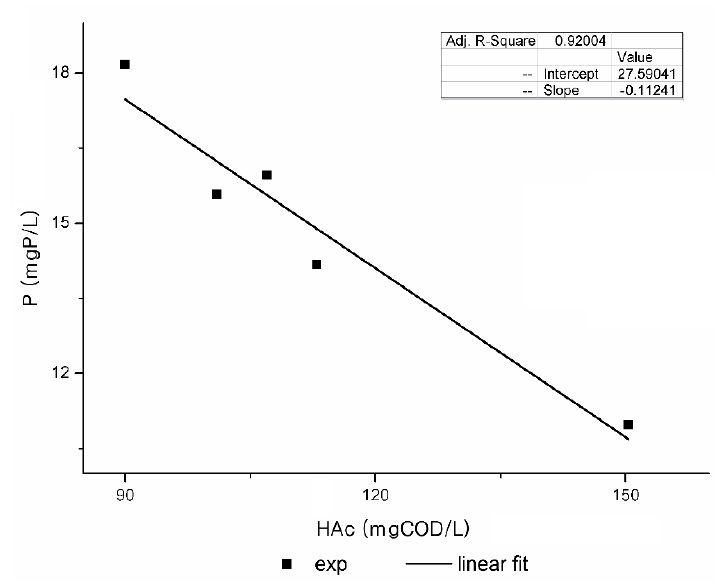
Figure 2. Linear fitting of P-PO 4 vs. COD for Y PO4 estimation.